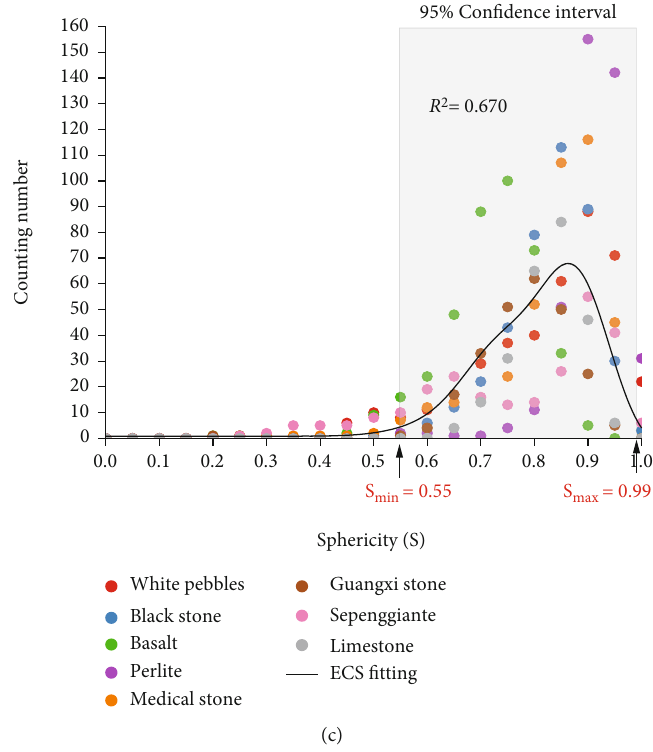
Figure 6: Counting number distribution for (a) aspect ratio, (b) convexity, and (c)